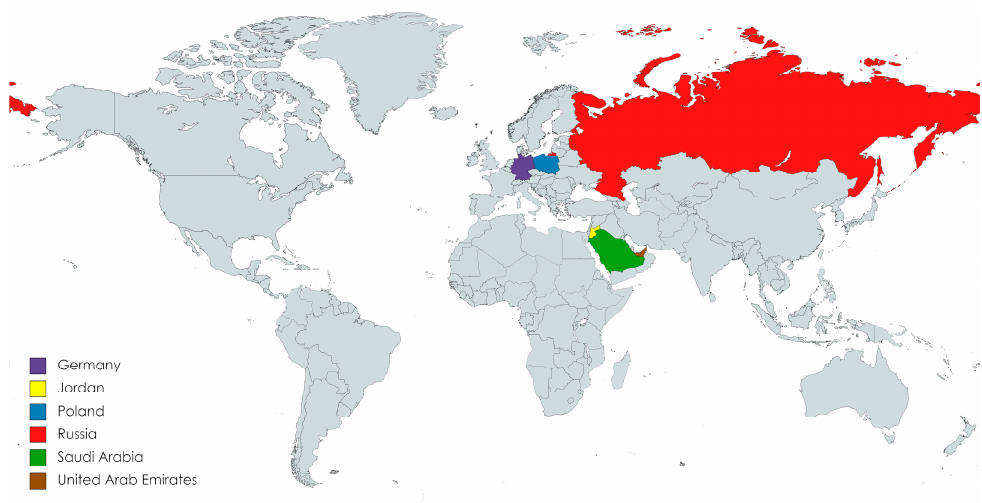
Figure 1. Authors’ countries of origin.